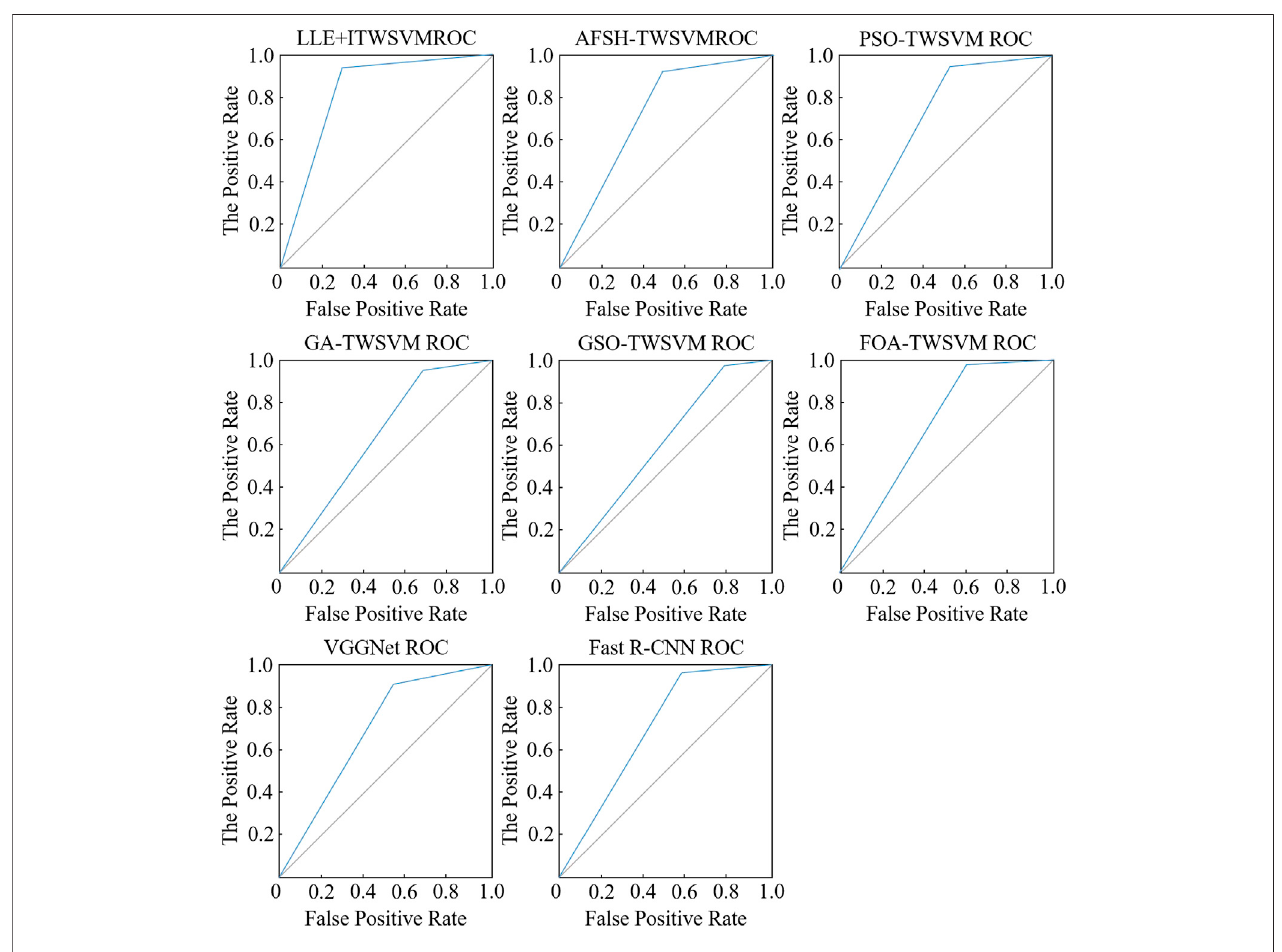
FIGURE 6 | ROC curves of different algorithms.